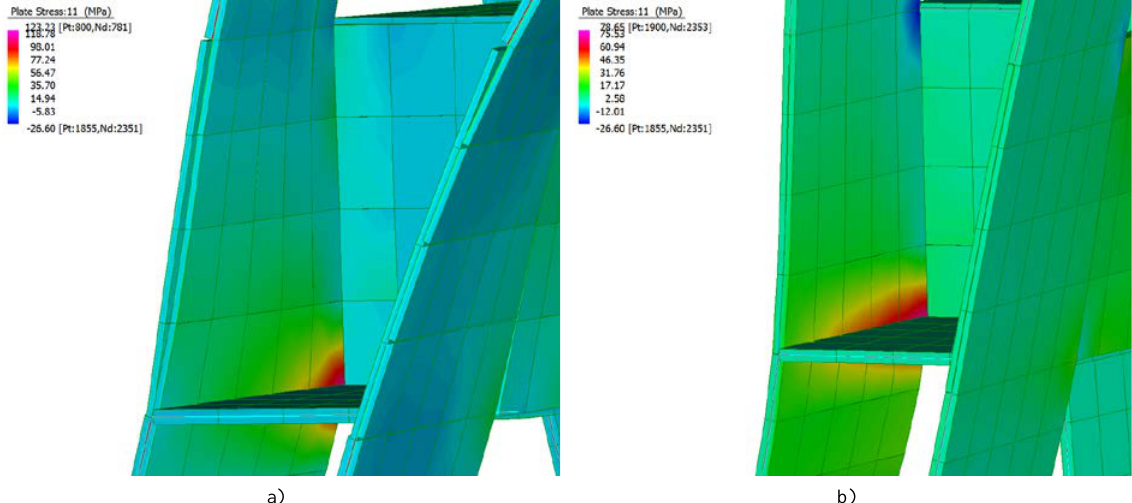
Fig. 6: Plate Stress details: a) structure with zero gap elements b) structure with monolithic linked glass